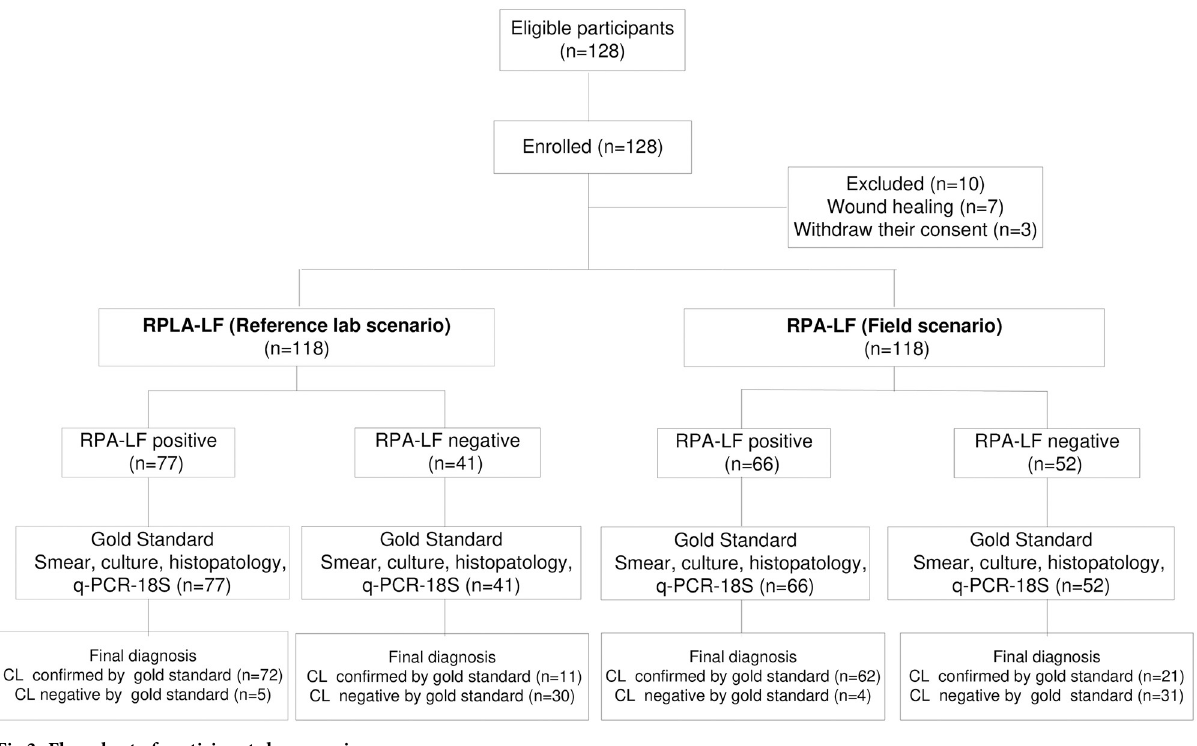
Fig 3. Flow chart of participants by